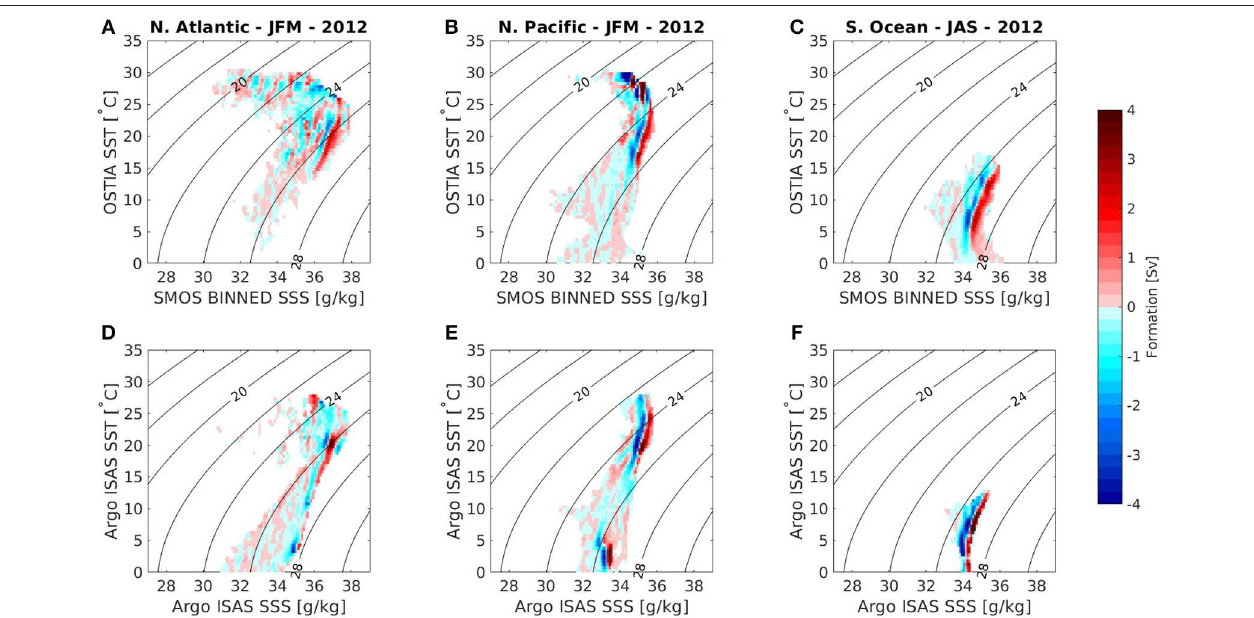
FIGURE 3 | Formation in θ –S space for the North Atlantic (left), North Pacific (middle) and Southern Ocean (right), derived from SMOS SSS and OSTIA SST (A–C) and Argo ISAS SSS and SST (D–F) averaged over the winter months in 2012.